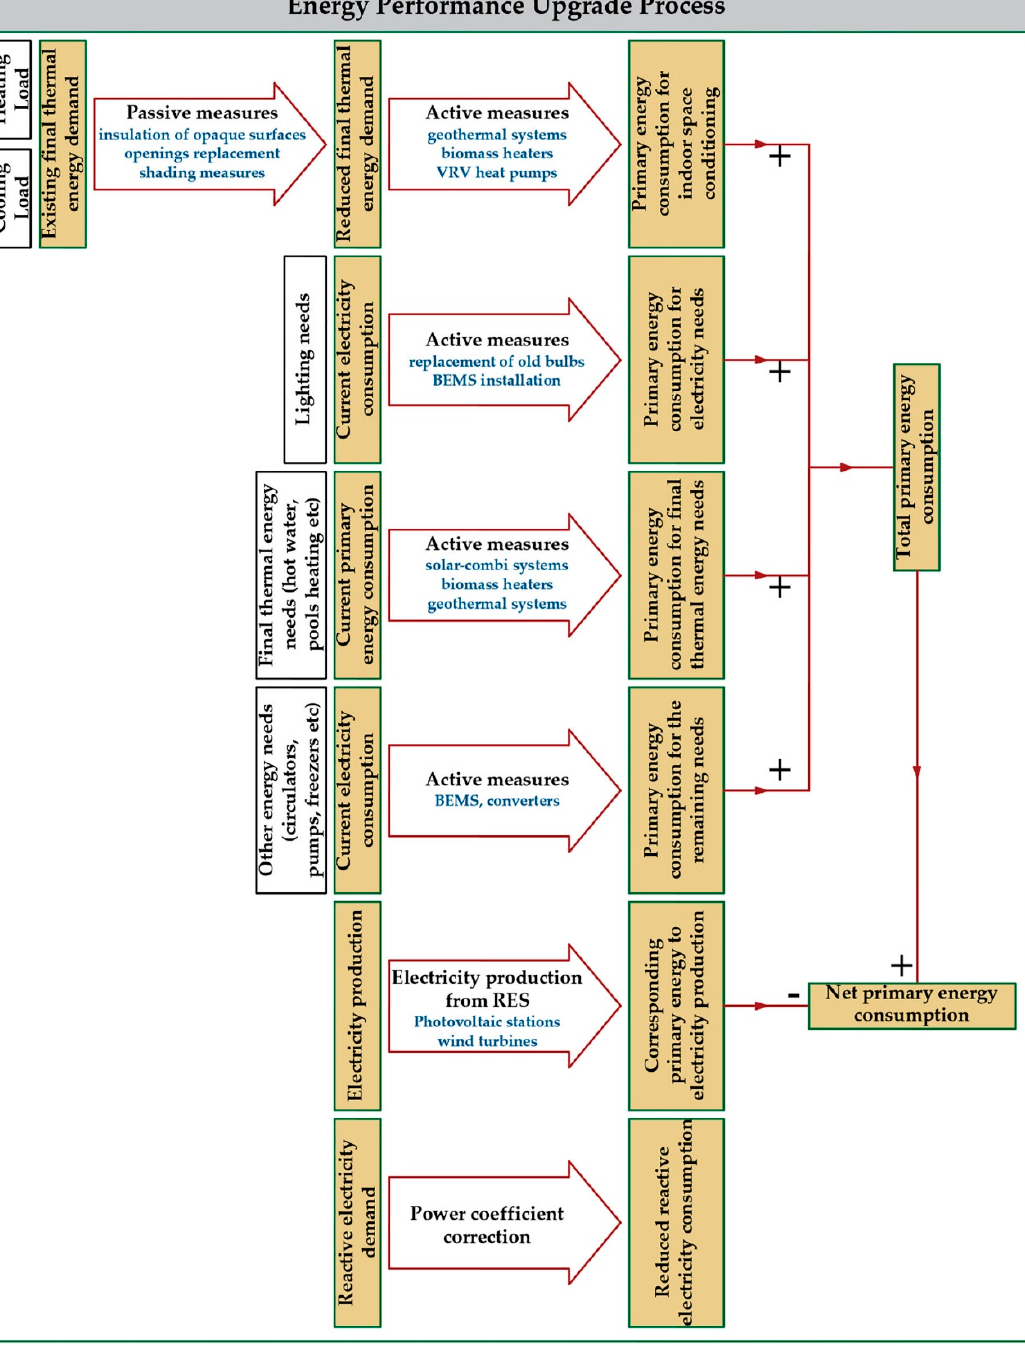
Figure 13. Typical logical diagram of an energy performance upgrade process.